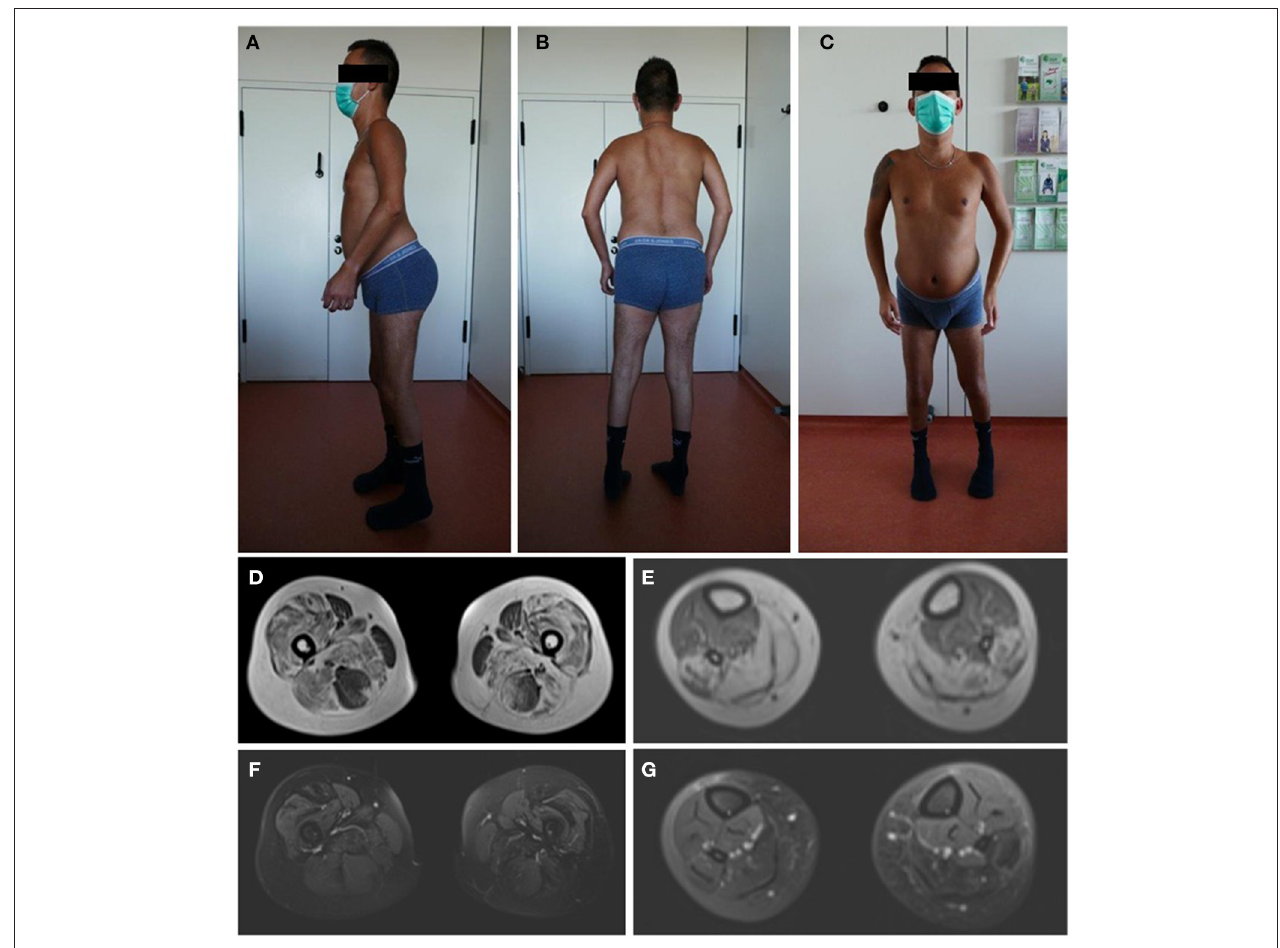
FIGURE 4 | Patients‘ phenotype correlates with LGMD-specific MRI pattern. Photographs of the patient demonstrate muscle atrophy of the legs and a rigid spine syndrome with joint contractures, most prominent in the elbows and achilles tendons (A–C) . T1-weighted imaging in axial orientation of the thighs and calves revealed fatty infiltration and atrophy of the muscles, predominantly of the quadriceps, adductor magnus and longus, biceps femoris and soleus with sparing of the gracilis, sartorius, semimembranosus muscle and anterior compartment of the lower leg (D,E) . Additional proton-density-weighted imaging of the lower extremity was performed with no sign of edema in the above mentioned muscle groups as a sign for active myositis (F,G)